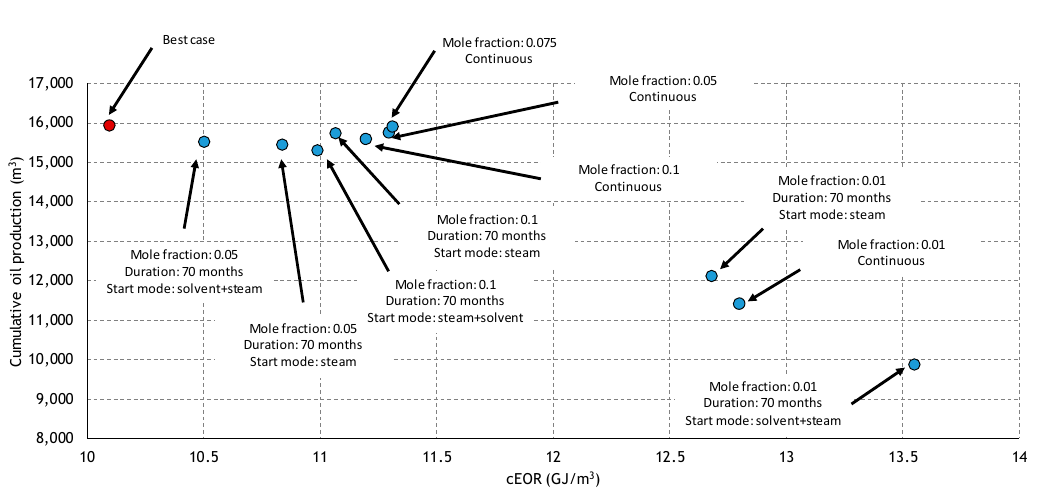
Figure 18. Comparison between the best cyclic ES-SAGD cases and other cases where the solvent is added continuously to the steam or trough cycles of different duration. In all of these cases, hexane is used as solvent.